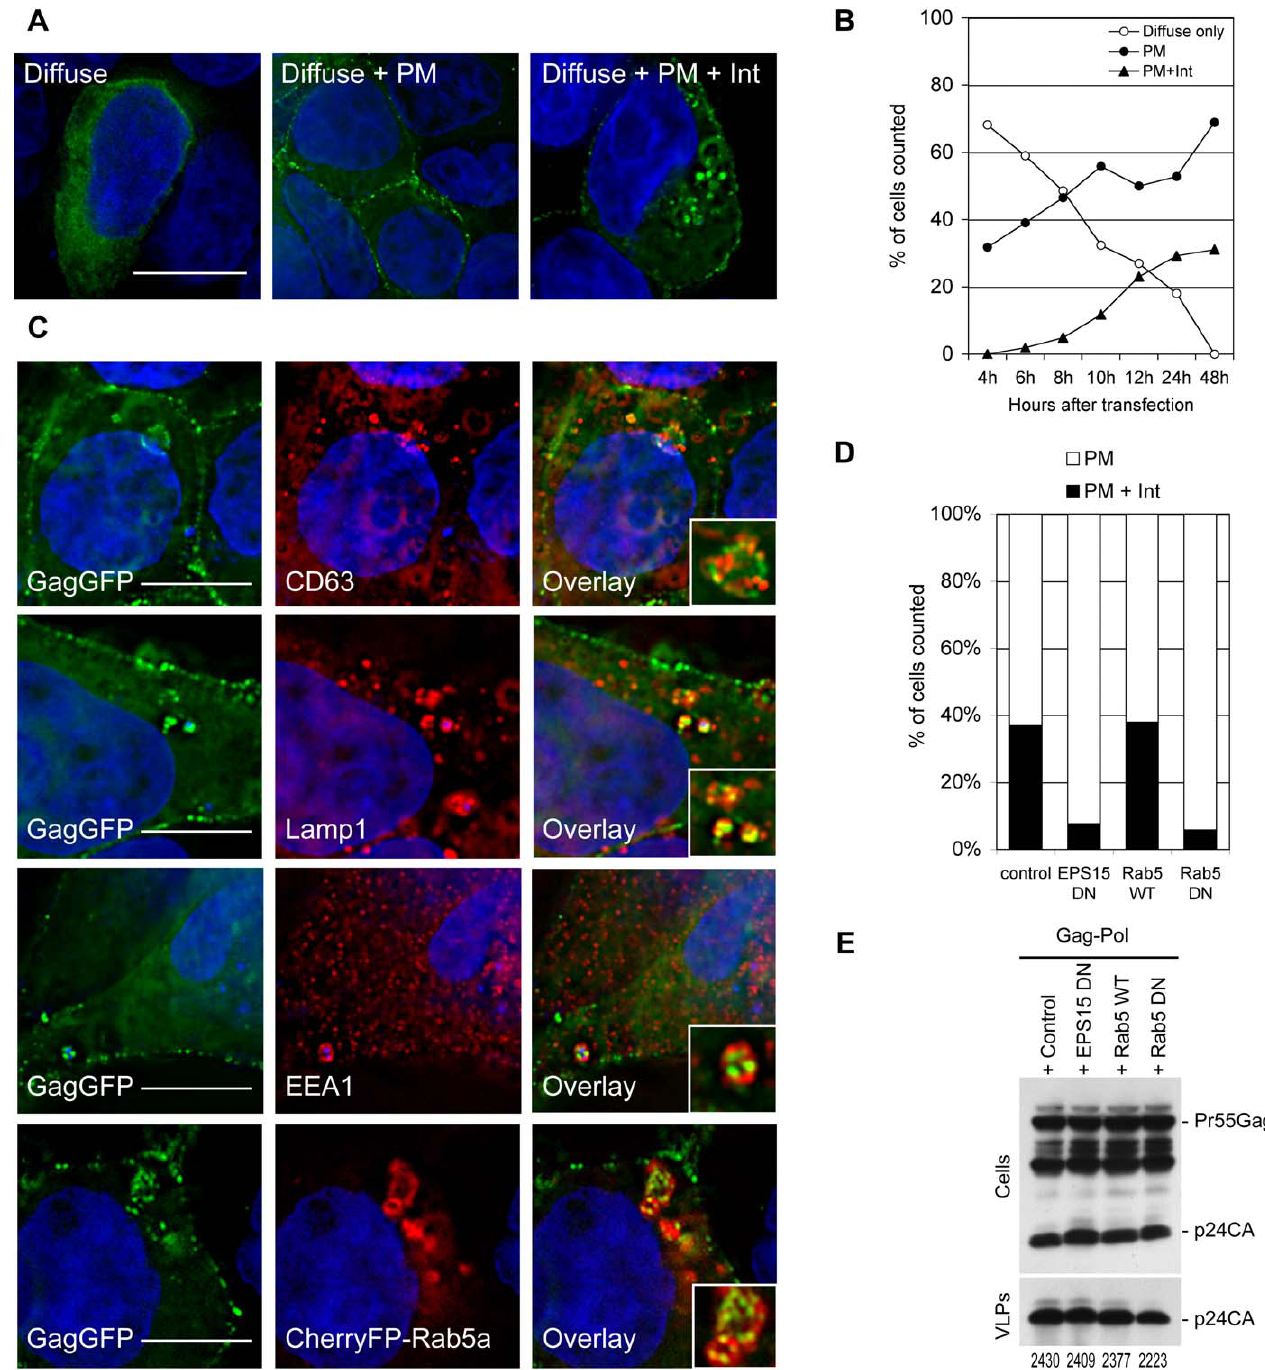
Figure 3. Accumulation of Gag at the PM Precedes Endosomal Accumulation, Which Can Be Prevented by Blocking Endocytosis (A) Distribution of Gag-GFP in 293T cells at 24-h post-transfection. Examples of cells exhibiting diffuse Gag only (left), PM accumulations (center), or PM þ internal (Int; right) accumulations are shown. Samples were stained with Hoechst 33258 (blue). Scale bars indicate 4 l m. (B) Quantification of Gag-GFP distribution in 293T cells. The number of cells in which Gag-GFP accumulation was observed at the PM, as internal and PM accumulations, or as a diffuse cytoplasmic signal only was counted. Approximately 100 cells were evaluated at each time point. (C) Gag-GFP accumulates at both early and late endosomes. 293T cells expressing Gag-GFP (green) were fixed at 24-h post-transfection and stained with anti-CD63, anti-Lamp1, or anti-EEA1 antibodies (red). Alternatively, cells were co-transfected with CherryFP-Rab5a (red). Cells were stained with Hoechst 33258 (blue). Insets show expanded views of individual Gag puncta. Scale bars, from top to bottom, indicate 4 l m, 2 l m, 8 l m, and 2 l m. (D) Quantification of Gag-GFP distribution in 293T in the presence of endocytosis inhibitors. 293T cells expressing Gag-GFP together with the indicated proteins were fixed at 24-h post-transfection and the proportion of cells (out of 100 counted) in which Gag was found at the PM, or both at internal accumulations and at the PM was determined. (E) Western blot analysis of 293T cells expressing HIV-1 Gag-Pol in the presence of endocytosis inhibitors. Samples were collected at 24-h post- transfection as indicated, and cell and virion lysates were probed with anti-HIV-1 CA antibodies. Numerical values below the blots indicate VLP p24CA signal intensities, derived by densitometry. DOI: 10.1371/journal.pbio.0040435.g003 PLoS Biology |